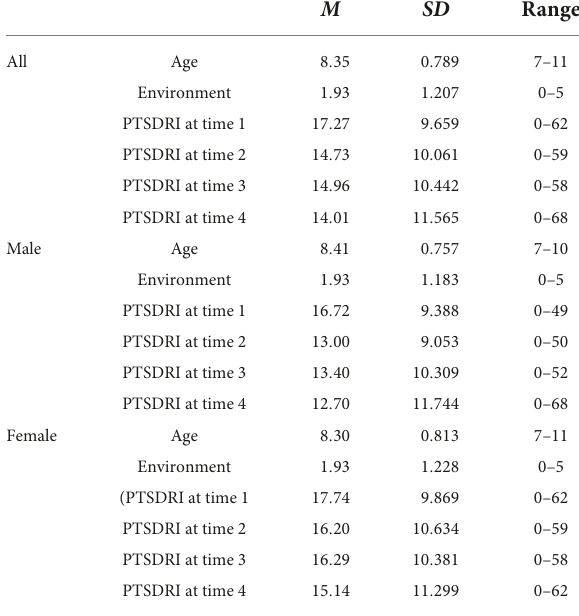
TABLE 1 The descriptive results of samples in our